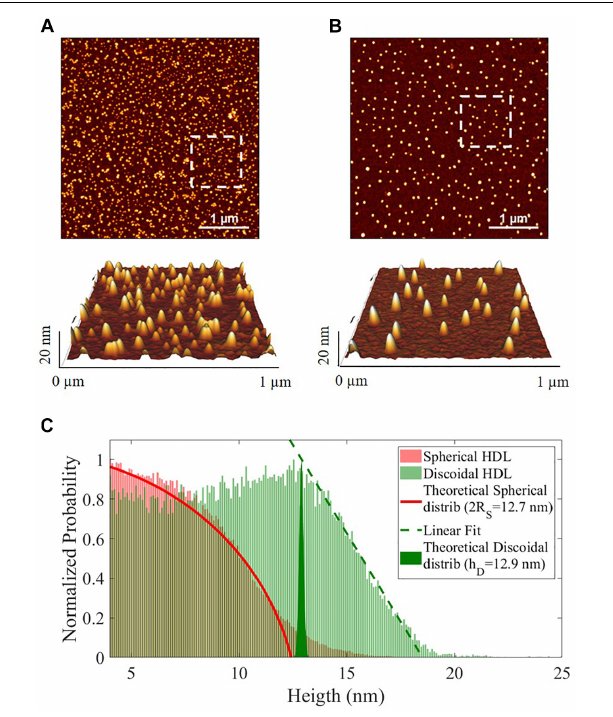
FIGURE 2 | Representative images of the morphology of HDL subclasses obtained by AFM imaging. (A) Discoidal and (B) spherical HDL on APTES functionalized mica (4 µ m 2 × 4 µ m 2 , 1024 × 1024-pixel, Z-scale 20 nm), with 3-dimensional projections of a 1 µ m 2 × 1 µ m 2 region (white squares in the images). (C) Normalized height statistical distributions of spherical (red) and discoidal (green) HDL in the range 4–25 nm. The red fit is the theoretical distribution for a sphere (2R S = 12.7 nm), the green filled area represents the δ -function (hD = 12.9 nm) and the green dotted line is the linear regression for the final part of the